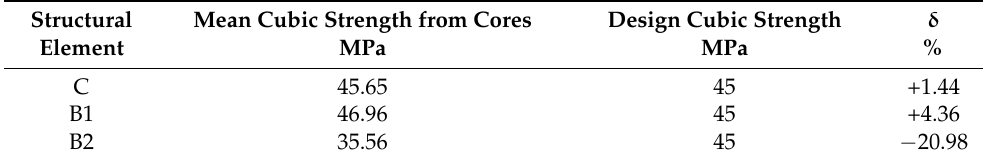
Table 4. Mean strength from core sampling vs. design